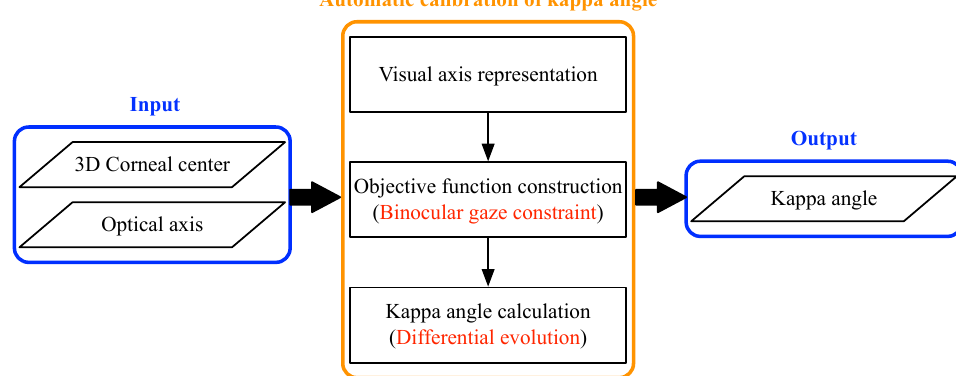
Figure 2. Procedure of the proposed